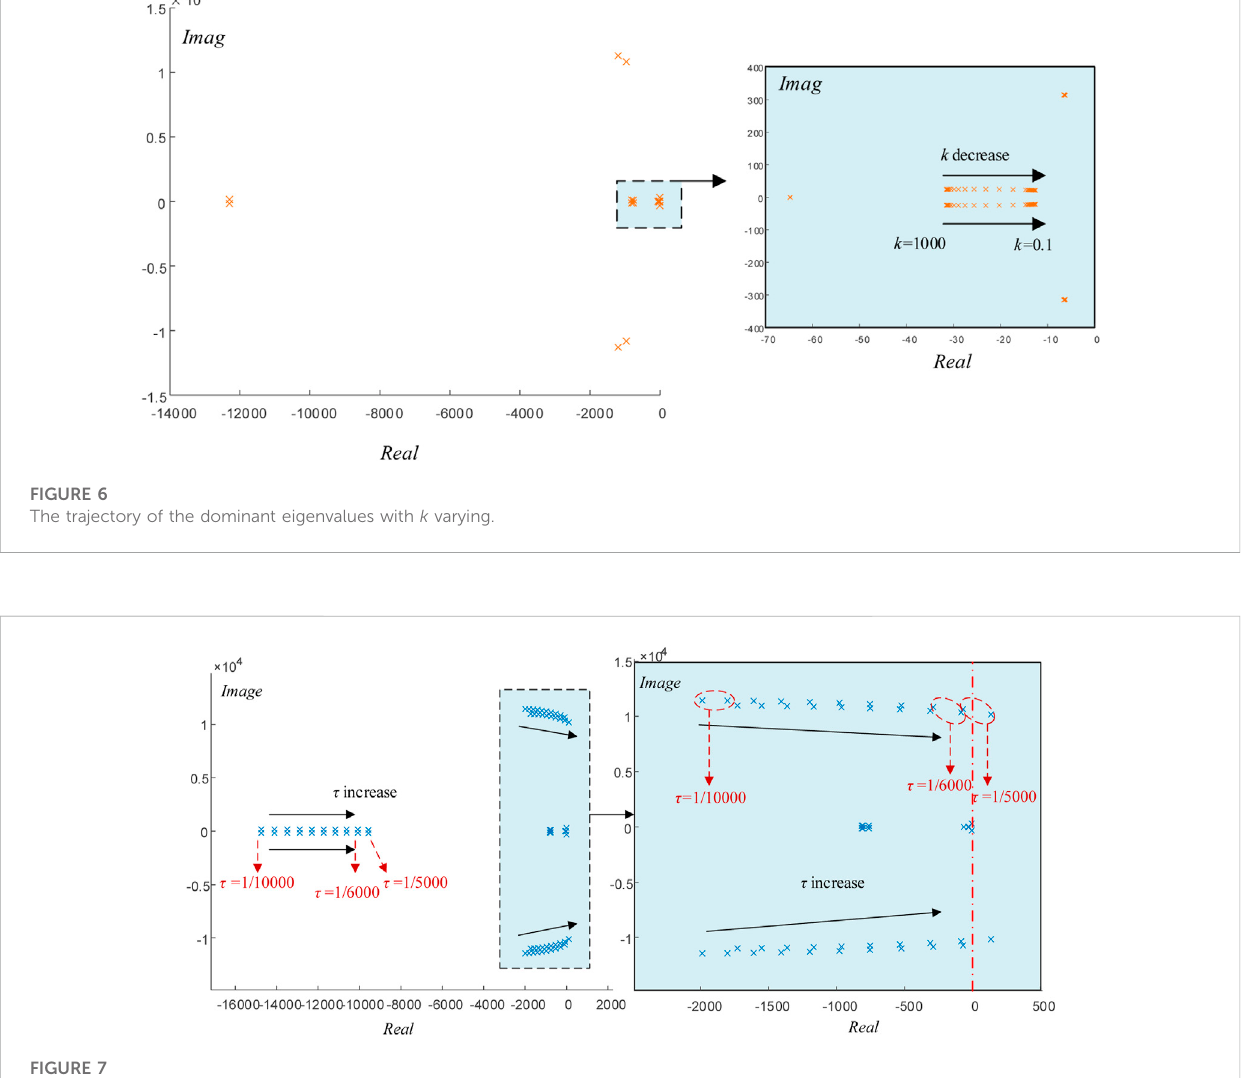
FIGURE 7 The trajectory of the dominant eigenvalues with τ